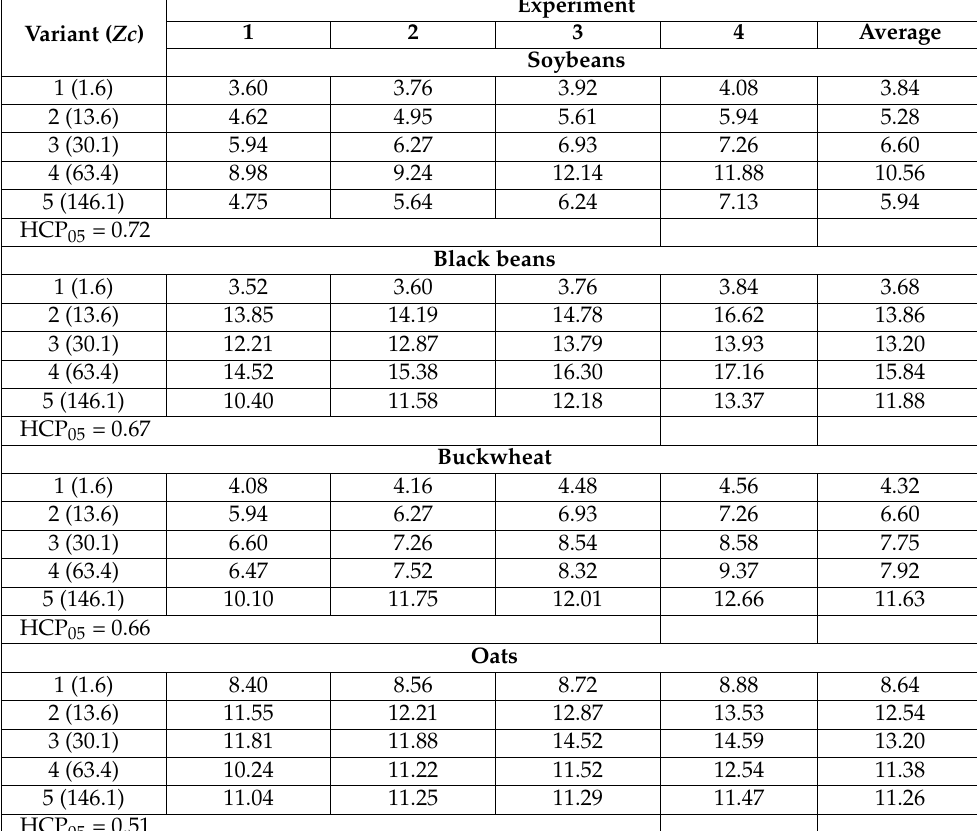
Table 2. Copper content in the phytomass of test crops, mg/kg. Variant ( Zc